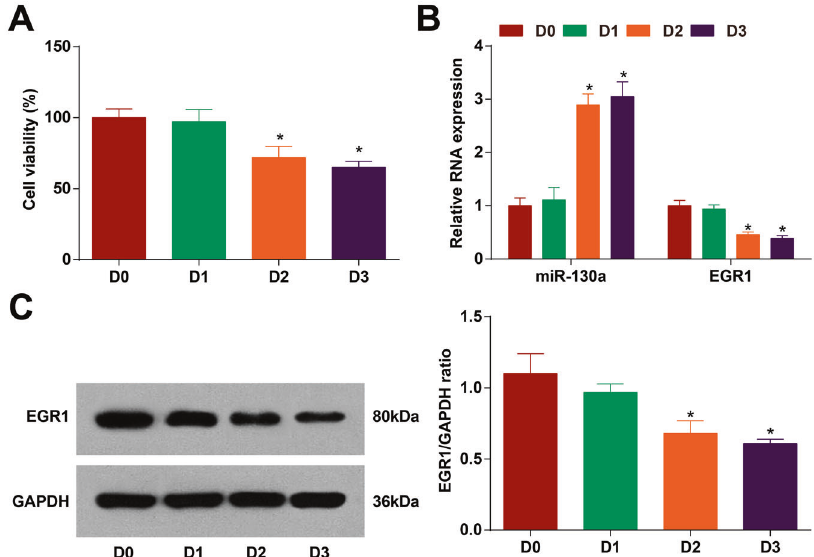
Fig. 2 HCC cell proliferation is suppressed by DEX. A Detection of cell viability by trypan blue staining; B, C miR-130a and EGR1 expression in HCC cells treated with DEX of different concentrations detected by RT-qPCR and western blot analysis (D0: DEX with a concentration of 0; D1: DEX with a concentration of 1 nmol/L; D2: DEX with a concentration of 10 nmol/L; D3: DEX with a concentration of 100 nmol/L). N = 3. The data were expressed as mean±standard deviation and compared by one-way ANOVA. * p < 0.05 vs. the D0